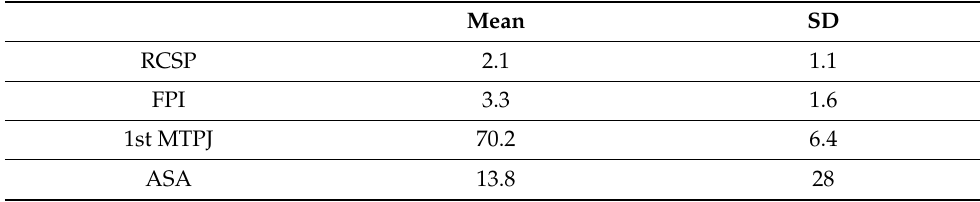
Table 1. Mean and SD of RCSP (valgus degree), 1st MTPJ, ASA (degree), and